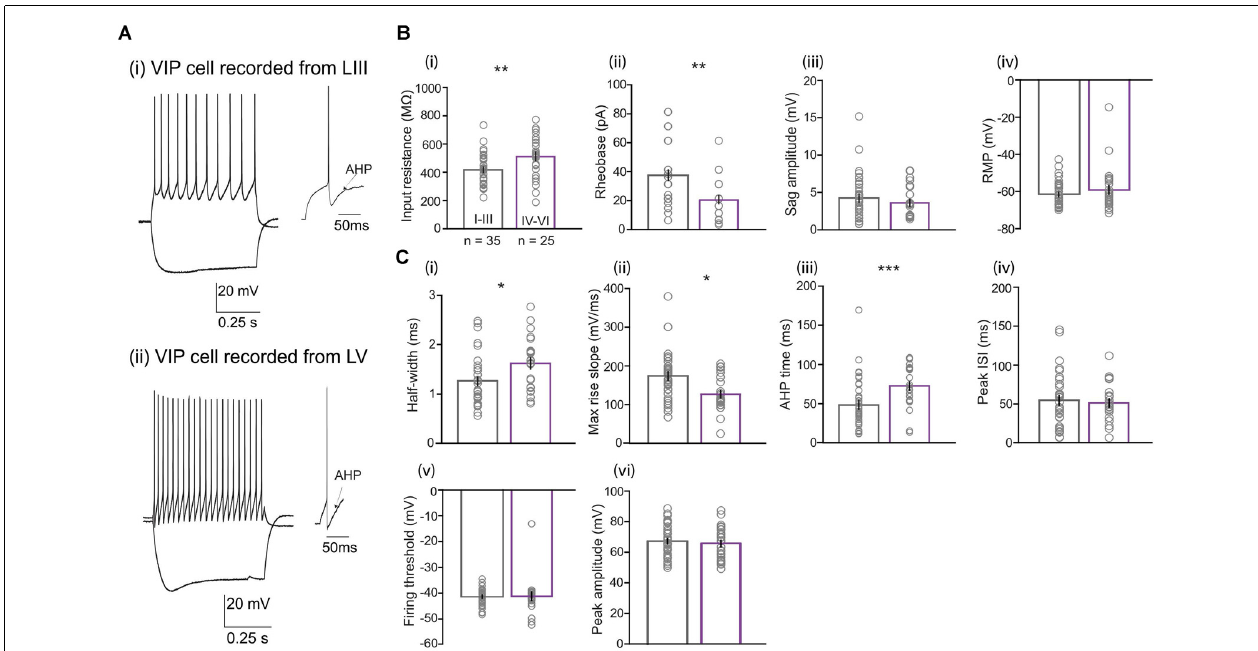
FIGURE 2 | Comparison of electrophysiological properties between LI-LIII and LIV-LVI VIP cells. (A) Examples of membrane potential responses to current steps ( − 80 pA for lower trace and +100 pA for upper trace) recorded from VIP cells located in the (i) superficial (LIII) and (ii) deep (LV) layers of the MEC. Examples of afterhyperpolarizations (AHP) following action potentials are also shown for the respective cells. (B) Passive and (C) active membrane properties for 60 VIP cells separated into layer I–III ( n = 35) and layers IV–VI ( n = 25). Except for (iii) sag amplitude where layer I–III ( n = 33) and layers IV–VI ( n = 24) and (iv) peak ISI where layer I–III ( n = 33) and layers IV–VI ( n = 22). Each bar represents a mean and error bars represent SEM. Significant differences were found in (B) (i) input resistance, (ii) rheobase and (C) (i) half-width, (ii) max rise slope, and (iii) AHP time (* p < 0.05, ** p < 0.01, *** p <